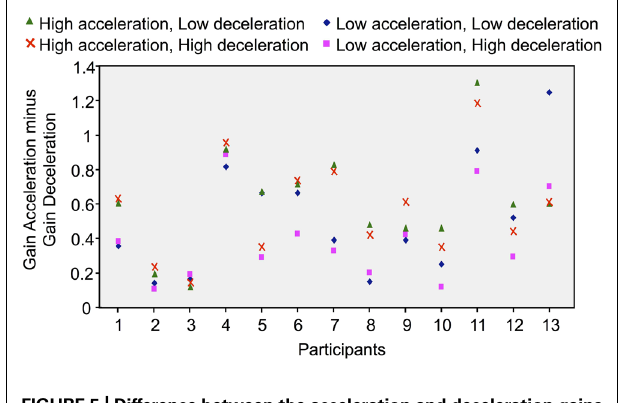
FIGURE 5 | Difference between the acceleration and deceleration gains computed in each rotational stimulus and for each participant (the positive values indicate that the gains were greater in the acceleration than in the